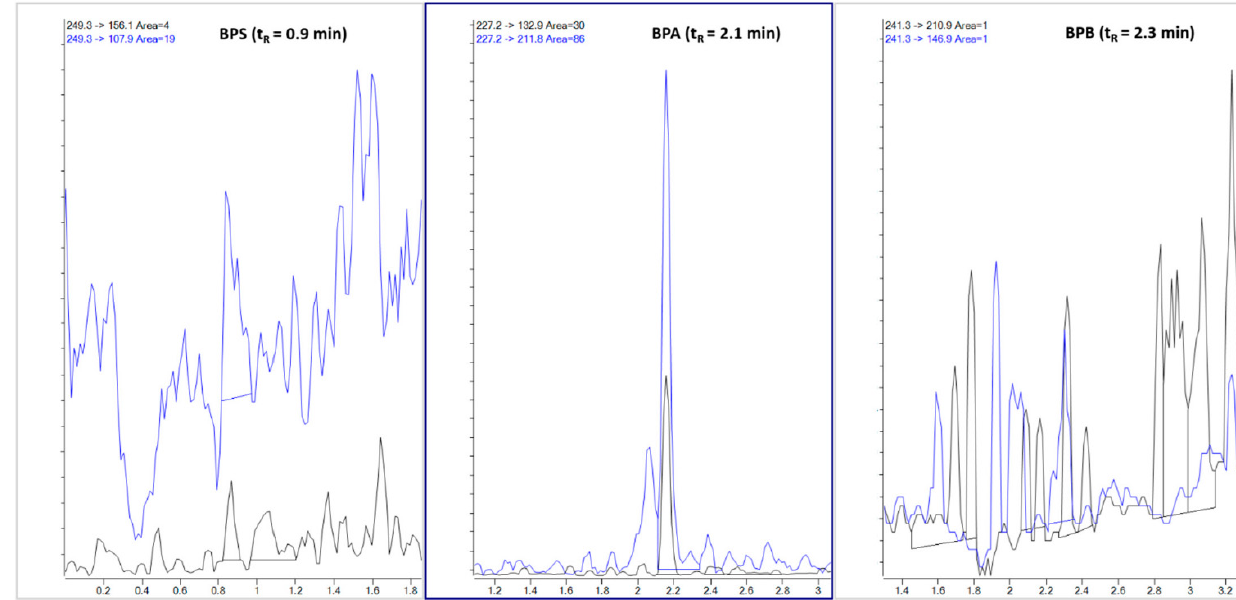
Figure 4. The -MRM ion chromatogram of a plant- based beverage sample contaminated with 2.6 ng/mL BPA. For each analyte, blue lines indicate the qualifier ions and black lines indicate the quantifier ions.